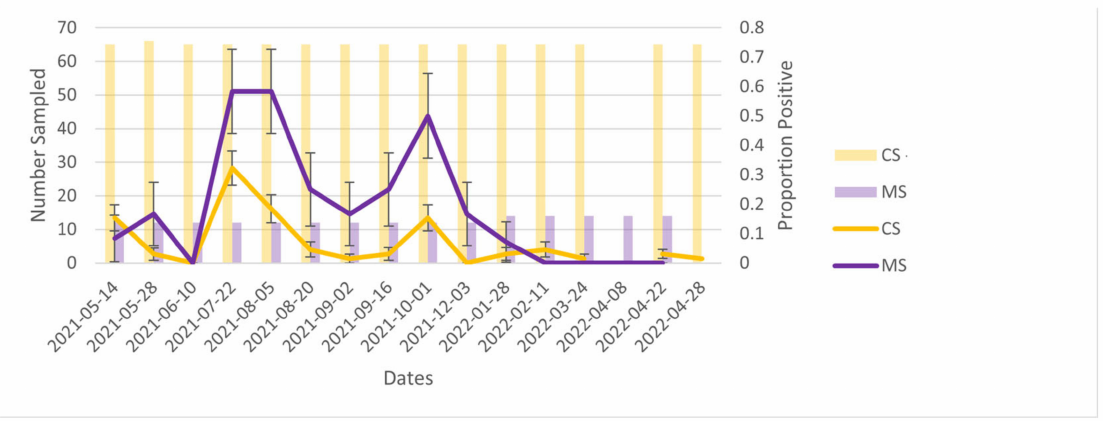
Figure 4. Comparing cage swabs (CS) and manure trough swabs (MS) throughout the outbreak. The farm was depopulated in April